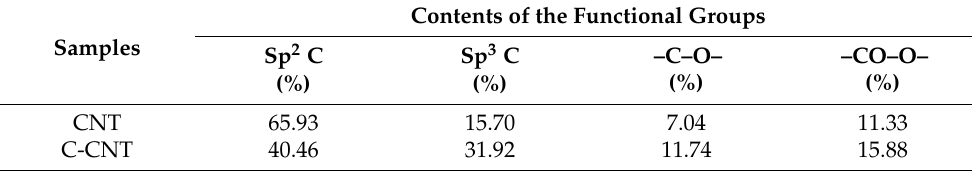
Figure 3. C1s XPS spectra of ( a ) CNT and ( b ) C-CNT, and XPS survey scans of ( c ) CNT and ( d ) C-CNT. Table 1. Content of the functional groups of CNT and C-CNT.